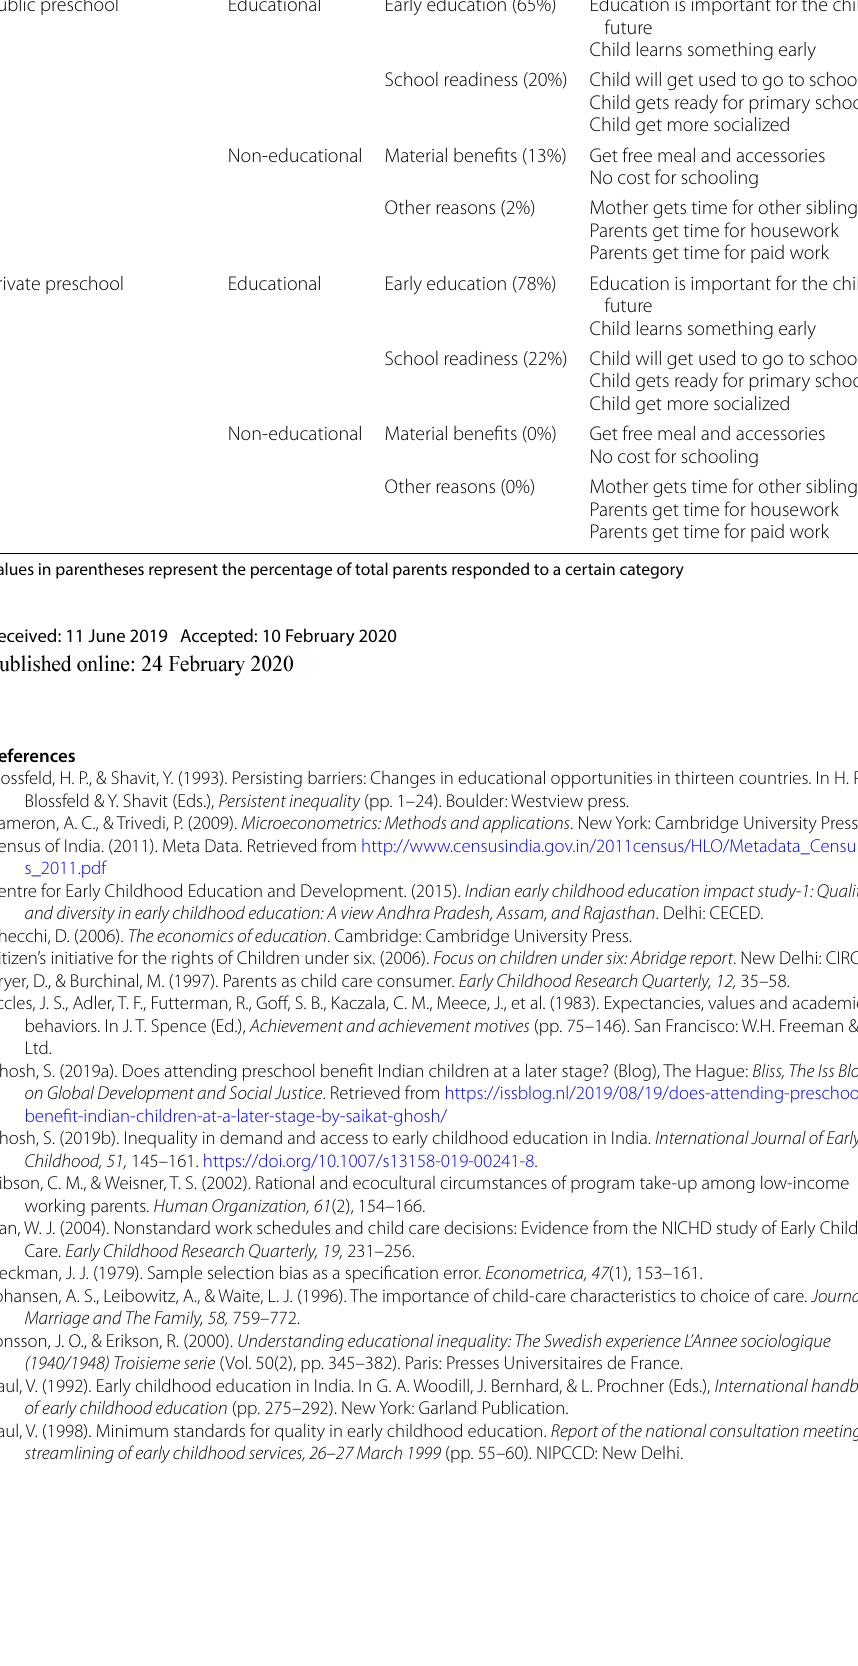
Table 6 Reasons for choosing a preschool type Type of preschool chosen Type of reasons Derived